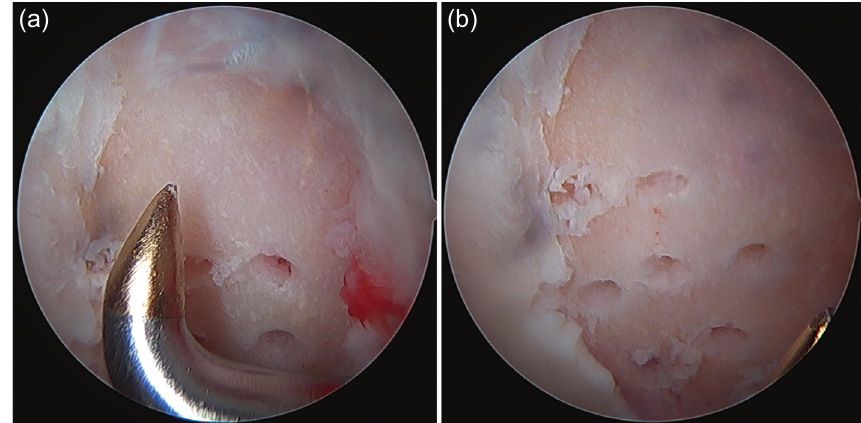
Figure 3. (a) The microfractures are performed systematically with an ideal depth of 4 mm and a distance of 3–4 mm between the perforations. (b) The entire surface should be covered with perforations including microfractures close to the edge of the